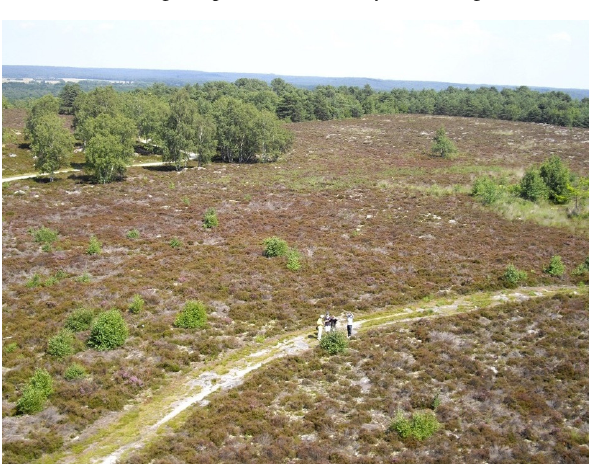
Figure 6: Example of an oblique image acquired int the field area each camera in one thread, we reach a synchronization rate of about 0.005 second. The frequency of shooting is an image per second (limited by the transfer rate and the speed to write images to the disk). We periodically readjust the exposure settings to